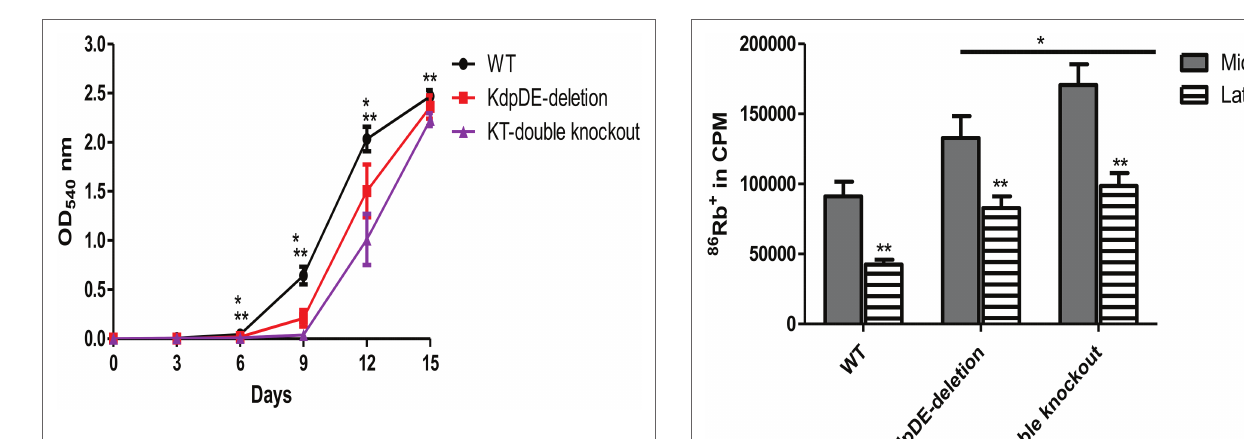
FIGURE 2 | The rates of planktonic growth of the WT and mutant strains of M. tuberculosis measured over 15 days. The results are of three different experiments and are expressed as the mean optical density (OD) ± SD at 540 nm. The numbers of bacteria were 8.8 × 10 4 ± 7.5 × 10 4 , 2.1 × 10 5 ± 1.8 × 10 5 , and 9.7 × 10 4 ± 1.3 × 10 5 cfu/ml for the WT, KdpDE- deletion and KT-double knockout mutant strains at D0, respectively. The OD values for the WT, KdpDE-deletion and KT-double knockout mutants at D6 were: 0.044 ± 0.024, 0.018 ± 0.006, and 0.009 ± 0.006; at D9: 0.644 ± 0.09, 0.208 ± 0.084, and 0.04 ± 0.006; at D12: 2.034 ± 0.126, 1.505 ± 0.269, and 1.011 ± 0.259; and at D15: 2.468 ± 0.0064, 2.360 ± 0.118, and 2.232 ± 0.065, respectively. * and ** represent p ≤ 0.05 for the KdpDE- deletion and KT-double knockout mutants in relation to the WT, respectively. *Values of p between the WT and KdpDE-deletion mutant at D6, D9, and D12 were 0.026, 0.0022, and 0.0022 respectively; ** Values of p between the WT and KT-double knockout at D6, D9, D12, and D15 were 0.0022 at each time point; Values of p between the KdpDE-deletion and KT-double knockout at D6, D9 and D12 were 0.0246, 0.0022, and 0.0260, respectively.